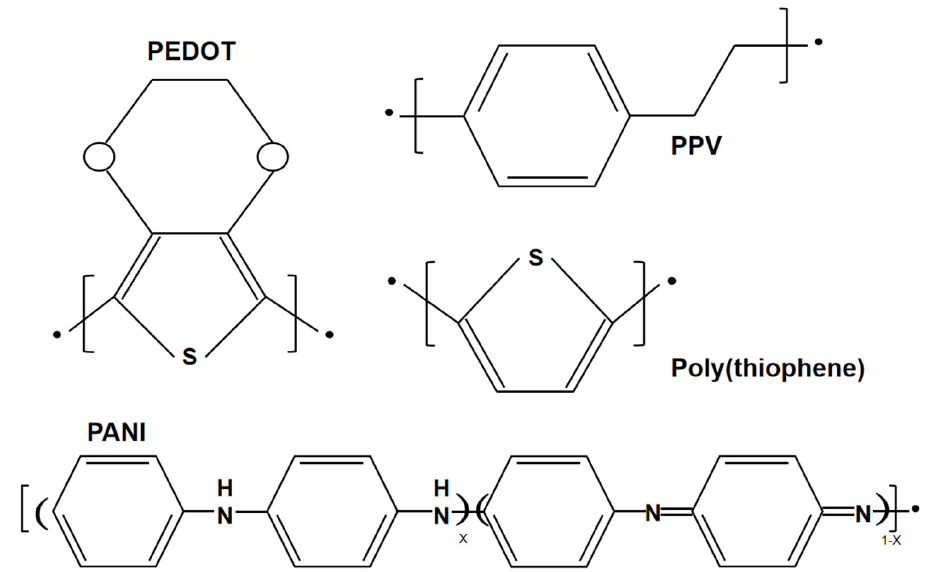
Figure 4. Structures of poly(3,4-ethylenedioxythiophene) (PEDOT), poly(thiophene) (PTh), poly(p-phenylene vinylene) (PPV), and poly(aniline) (PANI).